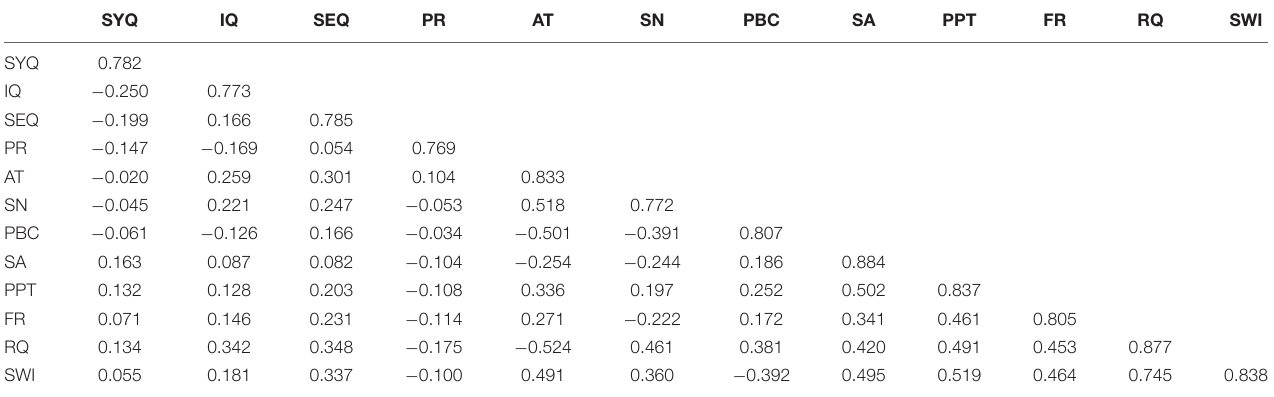
TABLE 3 | Discriminant validity (entire